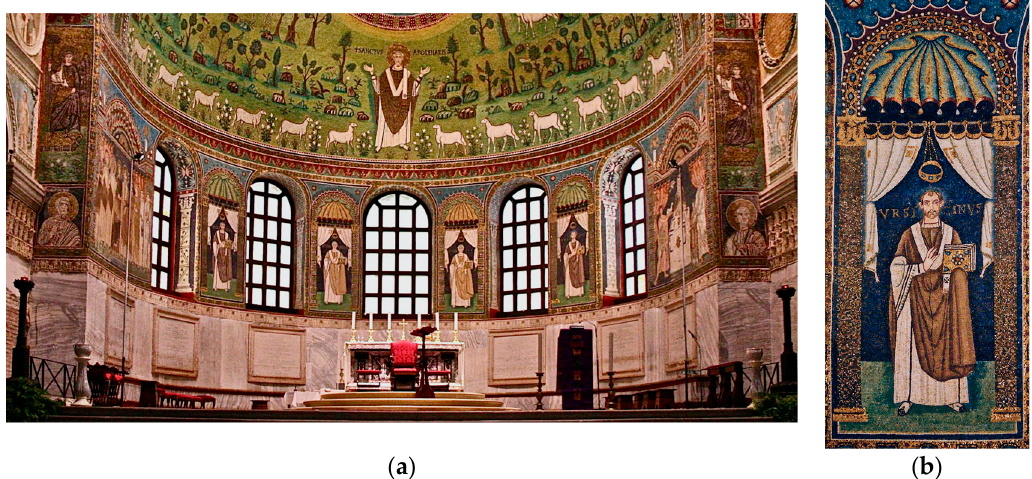
Figure 11. Apse mosaic, basilica of Sant’Apollinare, Classe: ( a ) the bishops (photo: author); ( b ) Bishop Ursicinus (photo: W. Borghini).